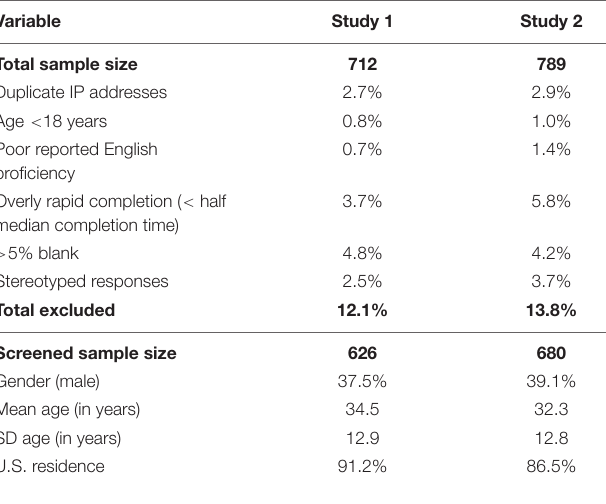
TABLE 1 | Participant